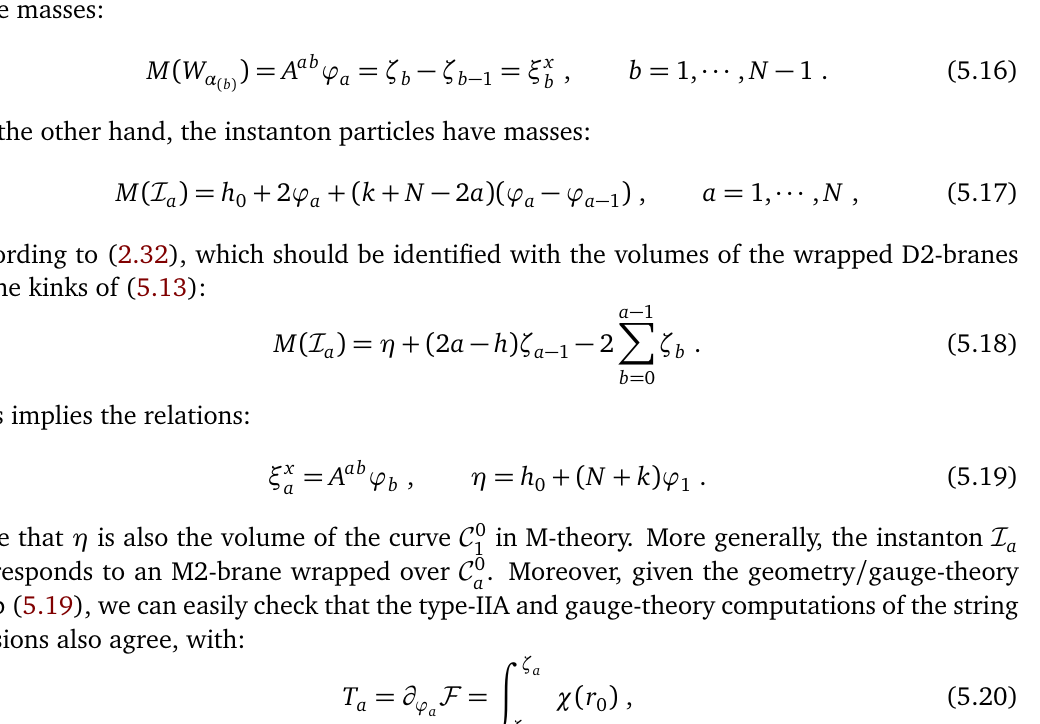
Figure 15: Type IIA profile for χ ( r ( N = 4, h = 5). Each area under the curve between ζ the tension T of an elementary magnetic a